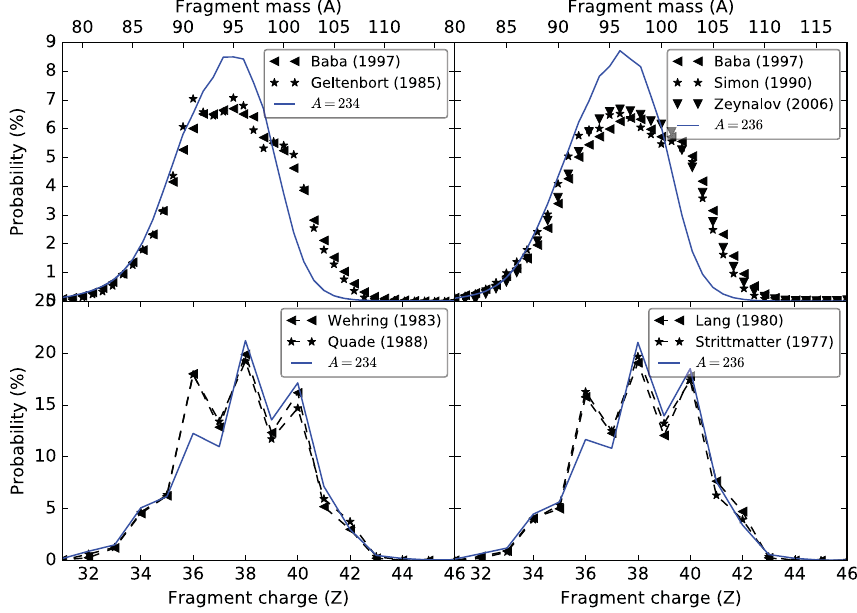
Figure 2. Mass (top) and charge(bottom) fragmentation distributions of the light fragment before prompt emission obtained for the reactions 235 U(n,f) (left) and 237 U(n,f) (right) at thermal neutron en- ergy compared with experimental data from